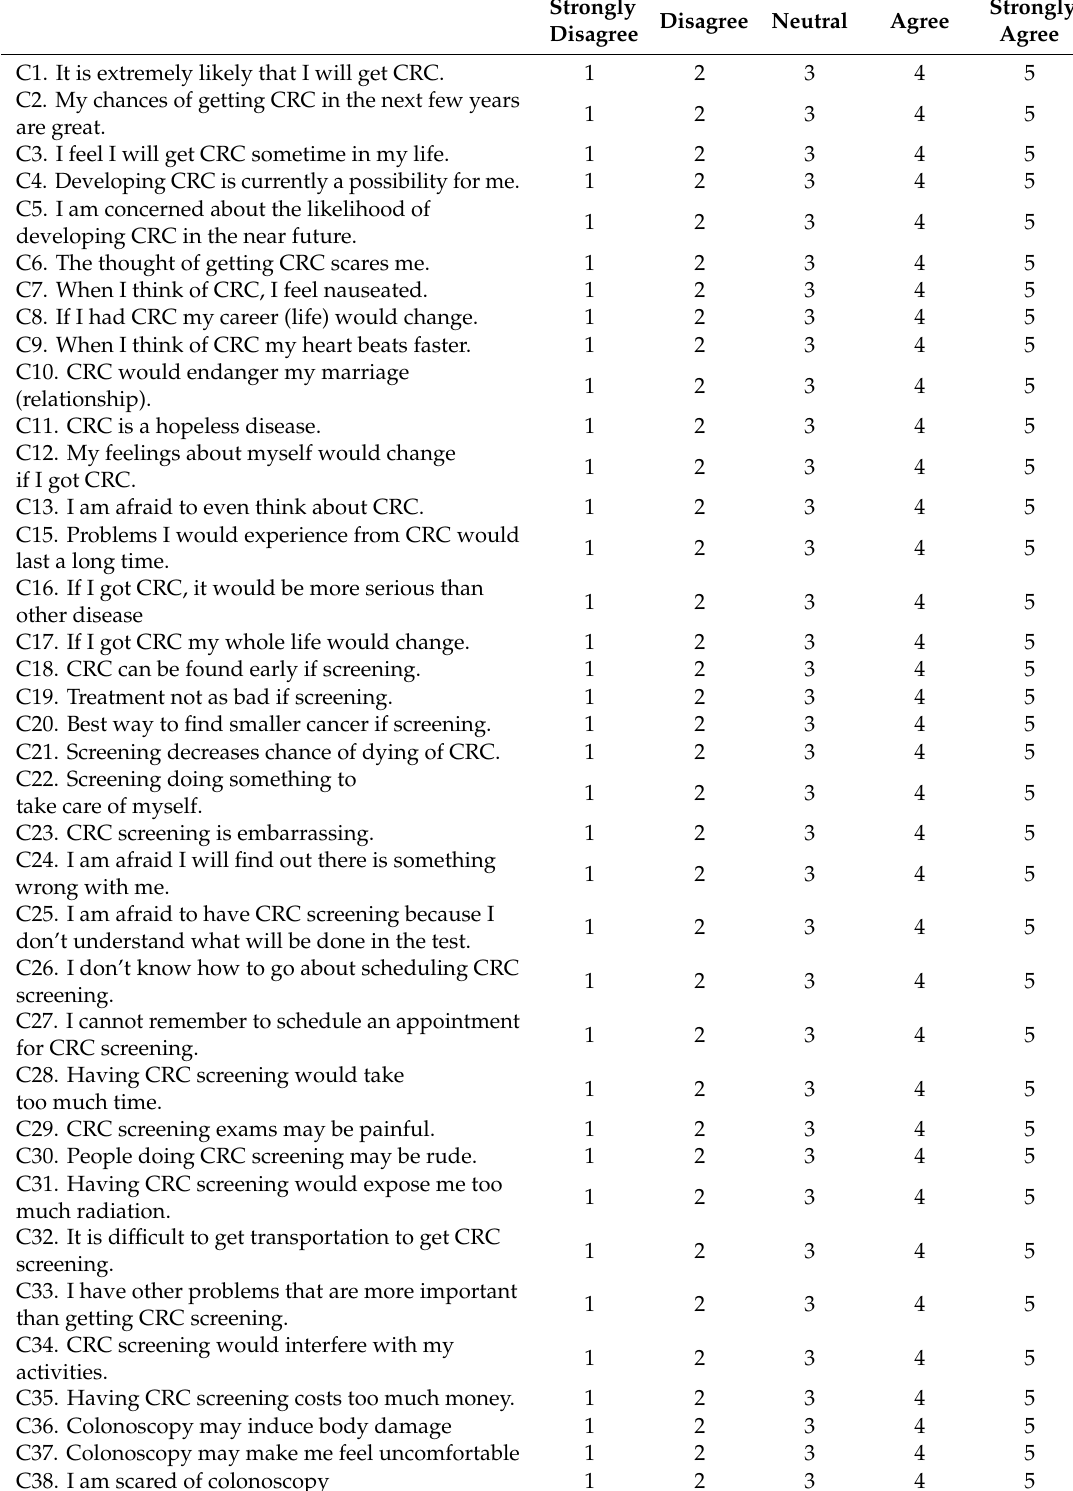
Table A1. The Revised Colorectal Cancer Perception and Screening Instrument.